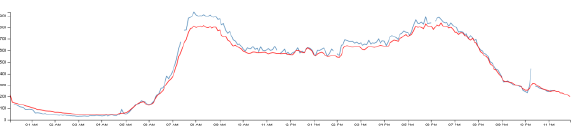
Figure 7. The graph showing the current day traffic profile (blue) and the mean traffic profile of the weekday (in